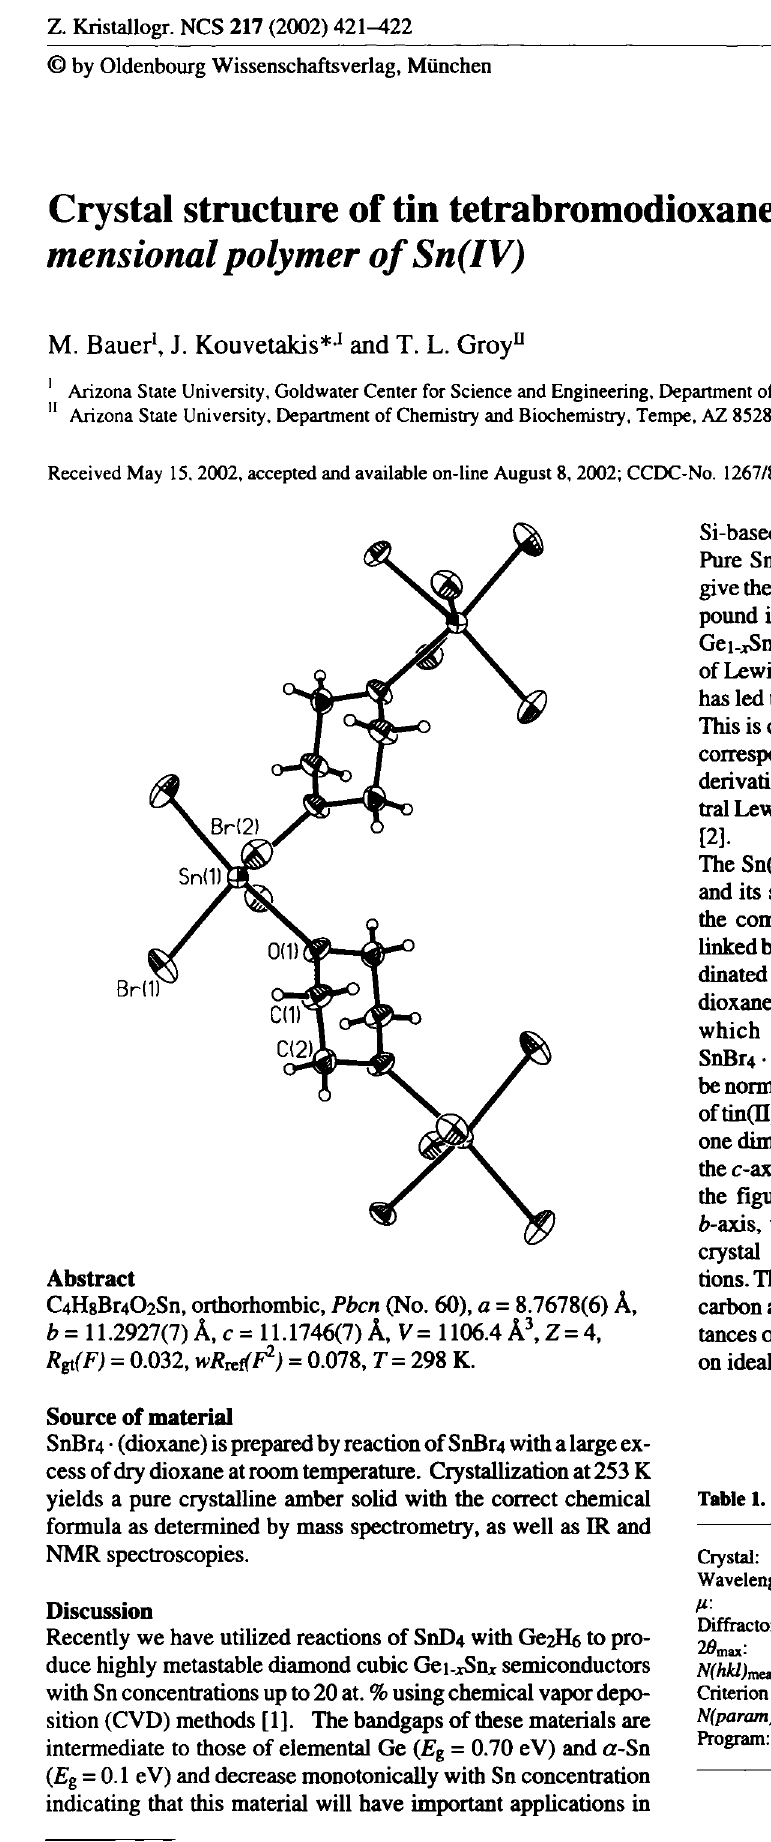
Table 1. Data collection and handling.